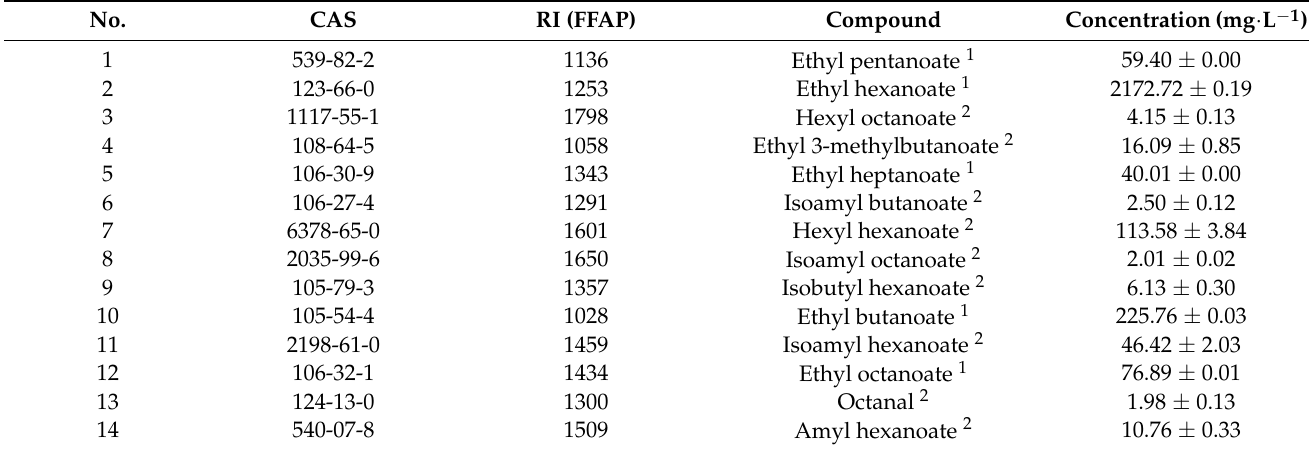
Table 2. Concentration of the 14 potential compounds, which may contribute to sweetness of Baijiu in sample S1 diluted to 50% ethanol content (detailed information of quantitative analysis is shown in the Table S5).